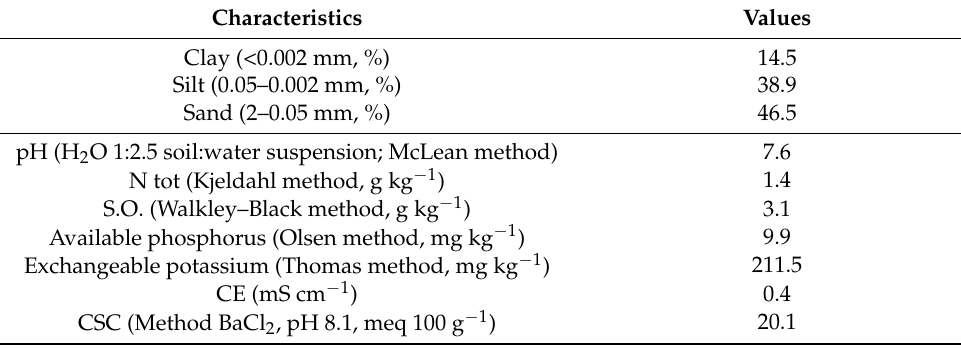
Table 3. Physical and chemical characteristics of the soil at the experimental